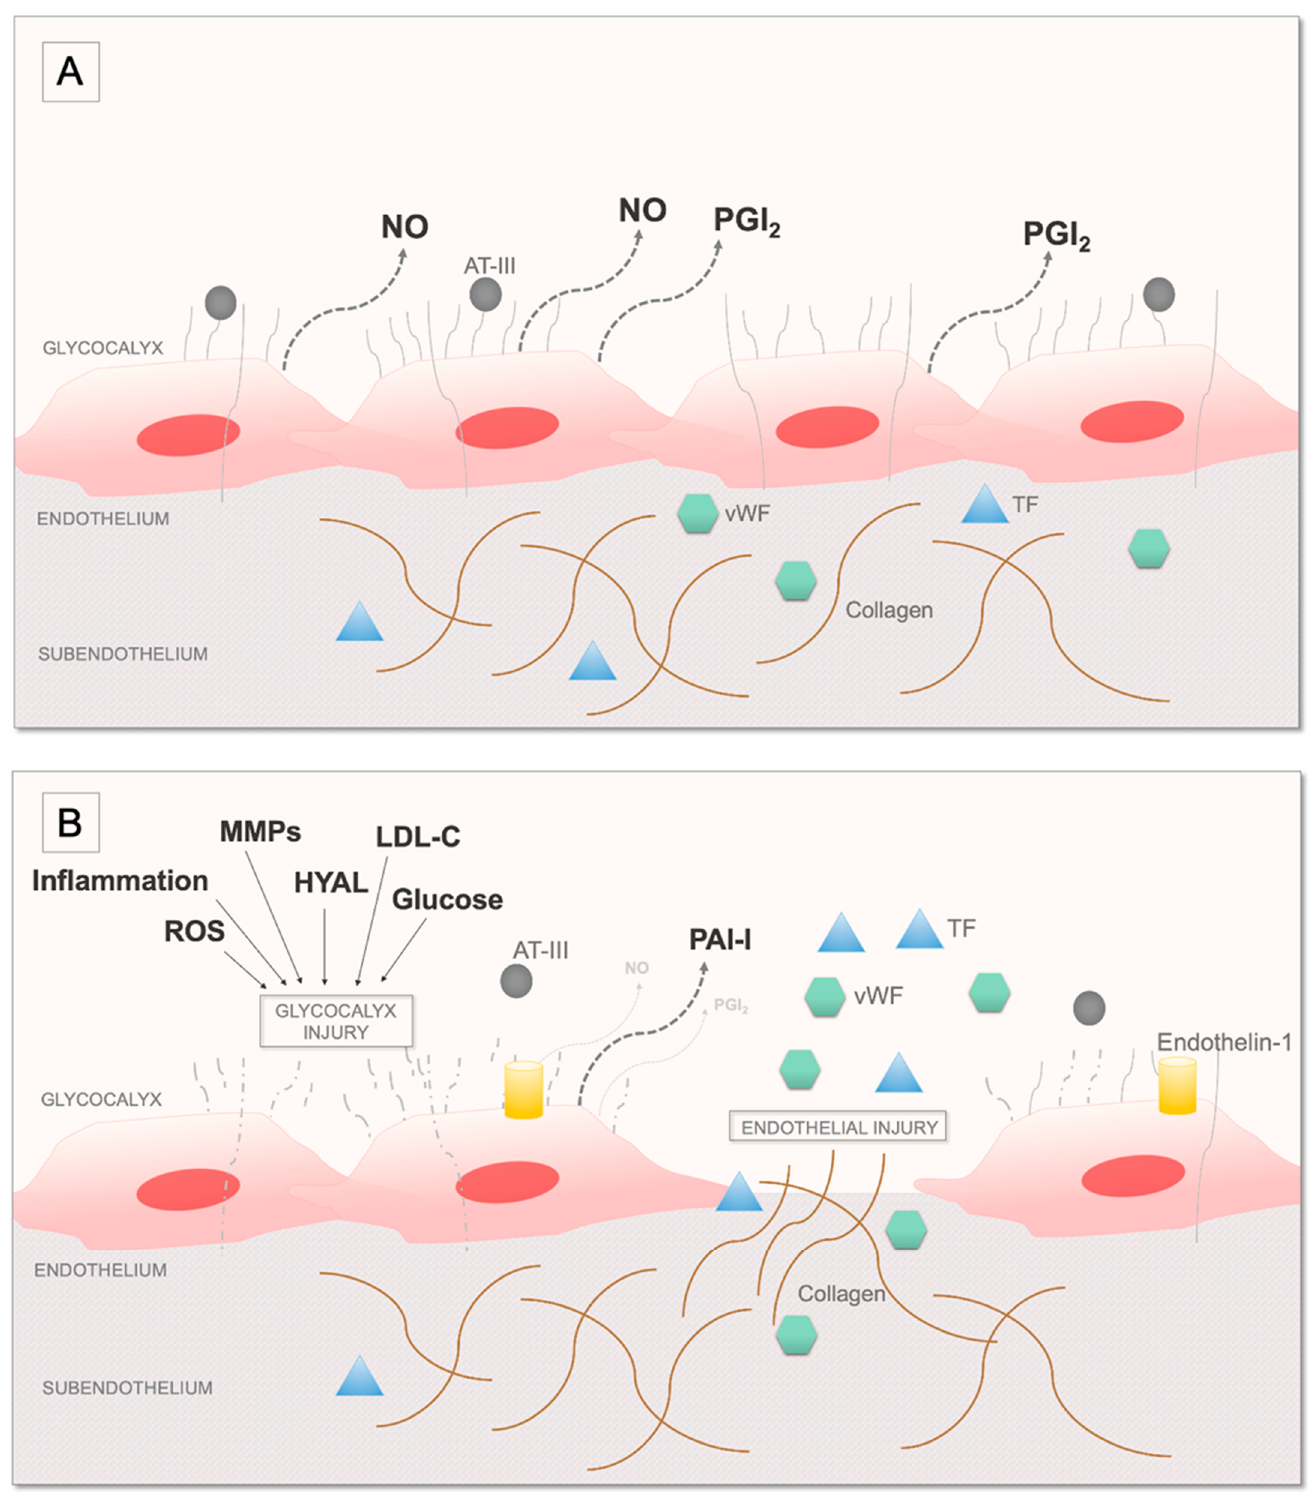
Figure 3. The role of endothelium in regulation of haemostasis ( A ) and endothelial injury ( B ) in OSA. AT-III—antithrombin III; HYAL—hyaluronidase; LDL-C—low-density lipoprotein cholesterol; MMPs—matrix metalloproteinases; NO—nitric oxide; PAI-1—plasminogen activator inhibitor-1; PGI2—prostacyclin; ROS—reactive oxygen species; TF—tissue factor; vWF—von Willebrand factor.